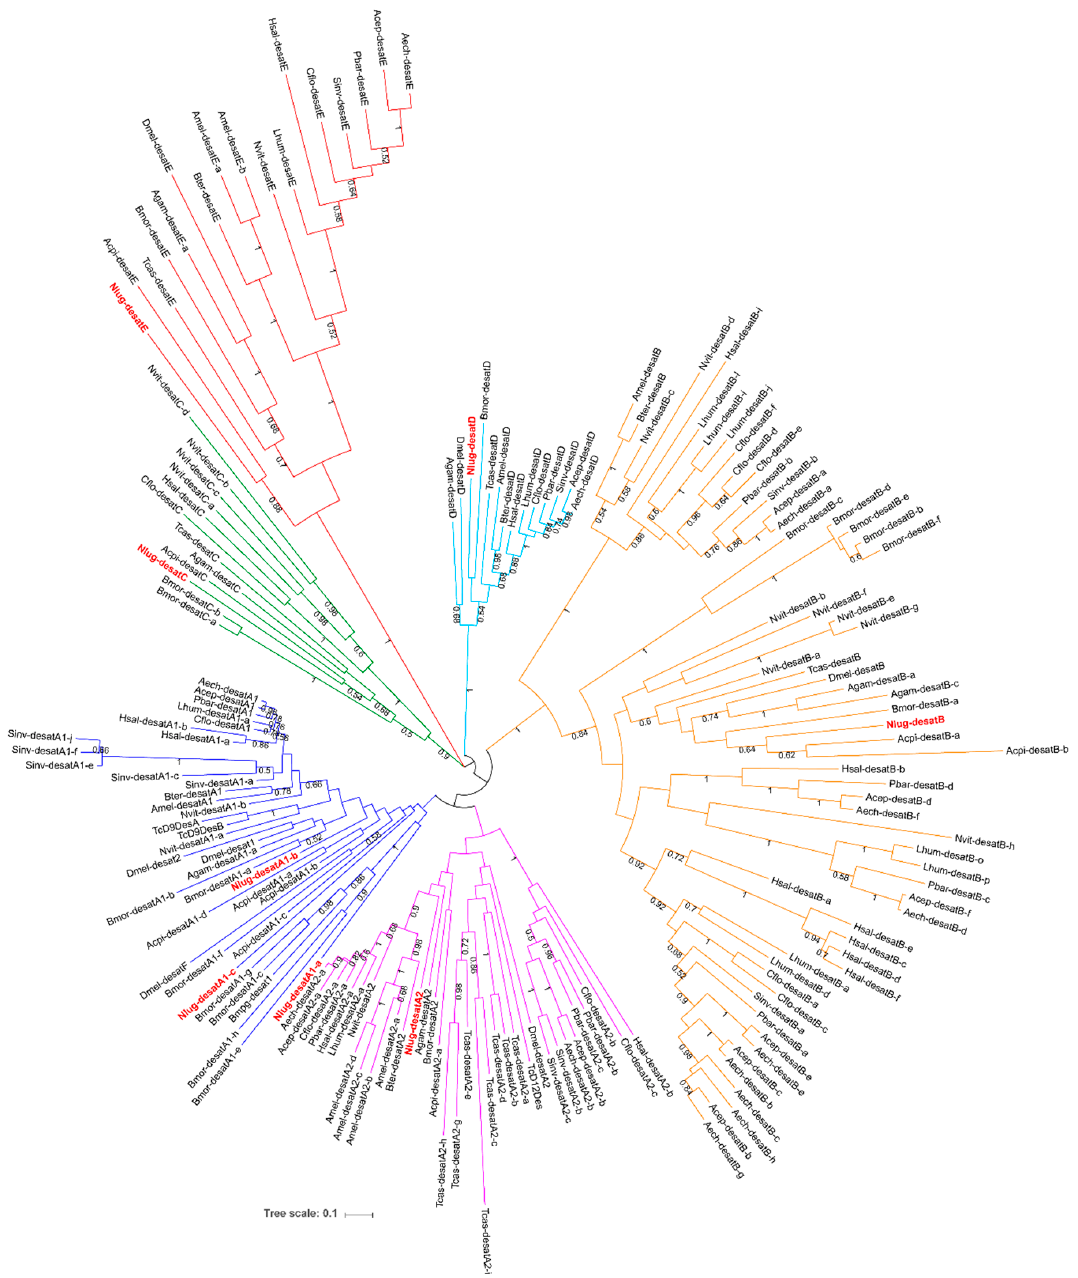
Figure 3. Maximum-likelihood phylogenetic tree of amino acid sequences of insect First Desaturase genes. The tree with the highest log likelihood ( − 58066.33) is shown. The proportion of trees in which the associated taxa clustered together in the bootstrap test (100 replicates) is shown next to the branches. There were a total of 311 positions in the final dataset derived from 177 genes of 16 species (Table S1). Gene names follow the updated nomenclature proposed by Helmkampf et al. (2015) [13], except for genes that have previously been characterized in the literature. Species are indicated by four-letter prefixes as follows: Aech, Acromyrmex echinatior ; Acep, Atta cephalotes ; Cflo, Camponotus floridanus ; Hsal, Harpegnathos saltator ; Lhum, Linepithema humile ; Pbar, Pogonomyrmex barbatus , Sinv, Solenopsis invicta ; Acpi, Acyrthosiphon pisum ; Amel, Apis mellifera ; Agam, Anopheles gambiae ; Bmor, Bombyx mori ; Bter, Bombus terrestris ; Dmel, Drosophila melanogaster ; Nvit, Nasonia vitripennis ; Tcas, Tribolium castaneum ; and Nlug, Nilaparvata lugens (in red). Branches of six subfamilies in the insect First Desaturase family are marked in different